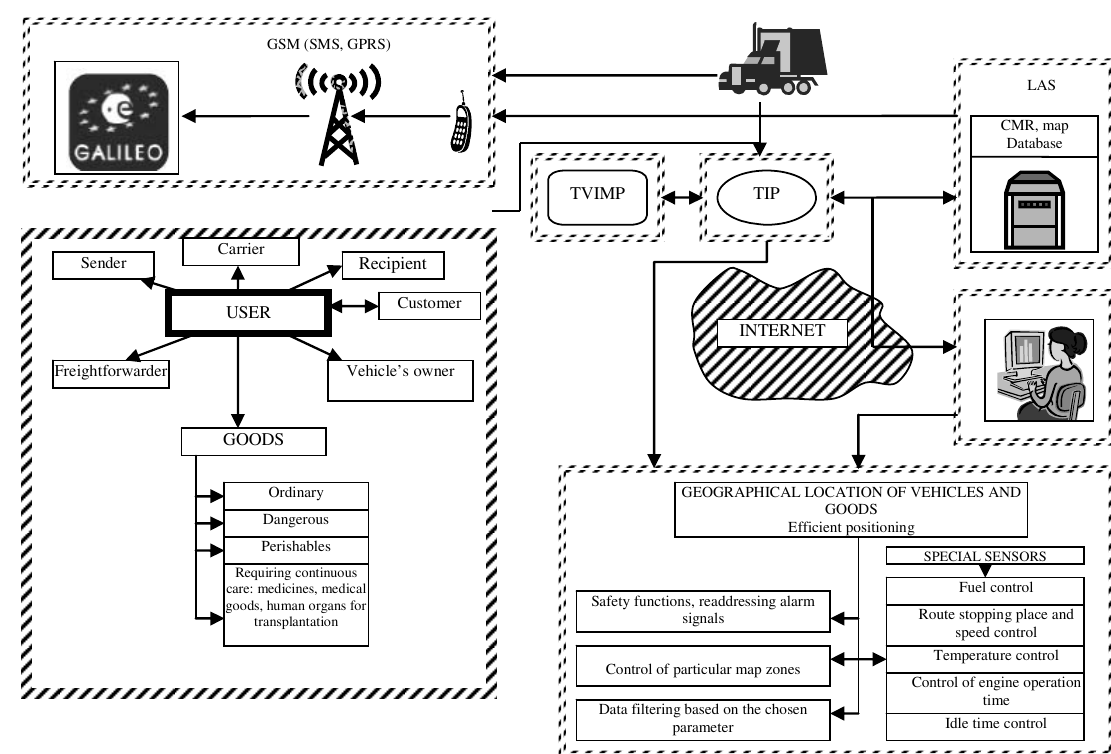
Fig 2. A system of remote identification of vehicles and